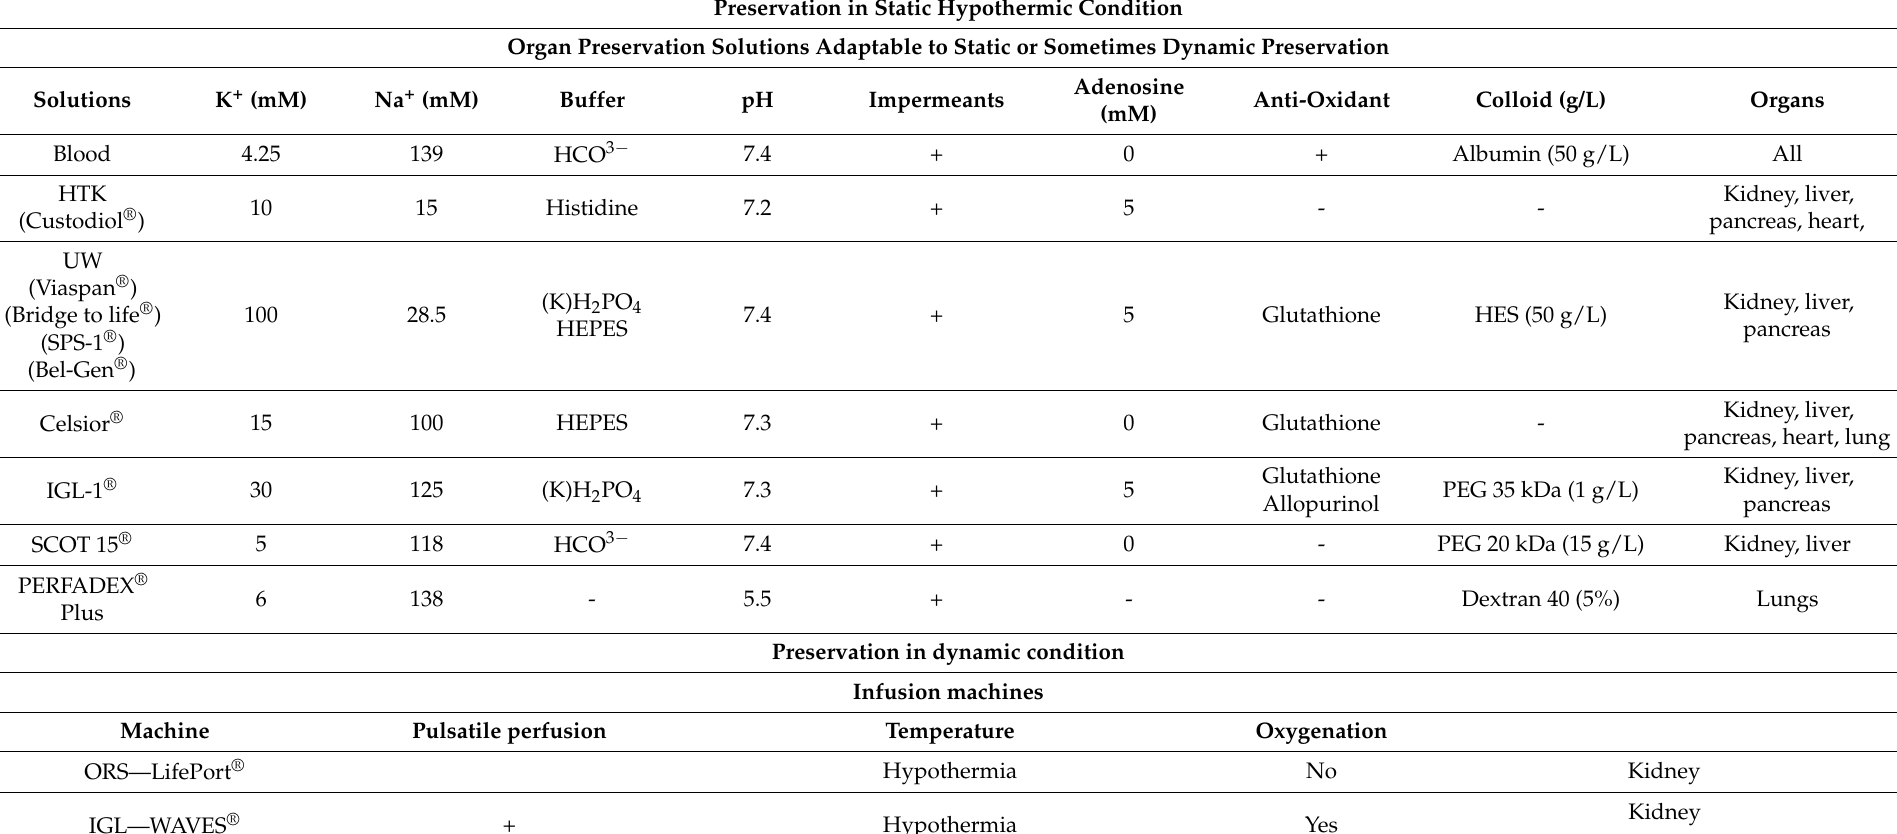
Table 2. Some of the most common preservation solutions and machines used in the